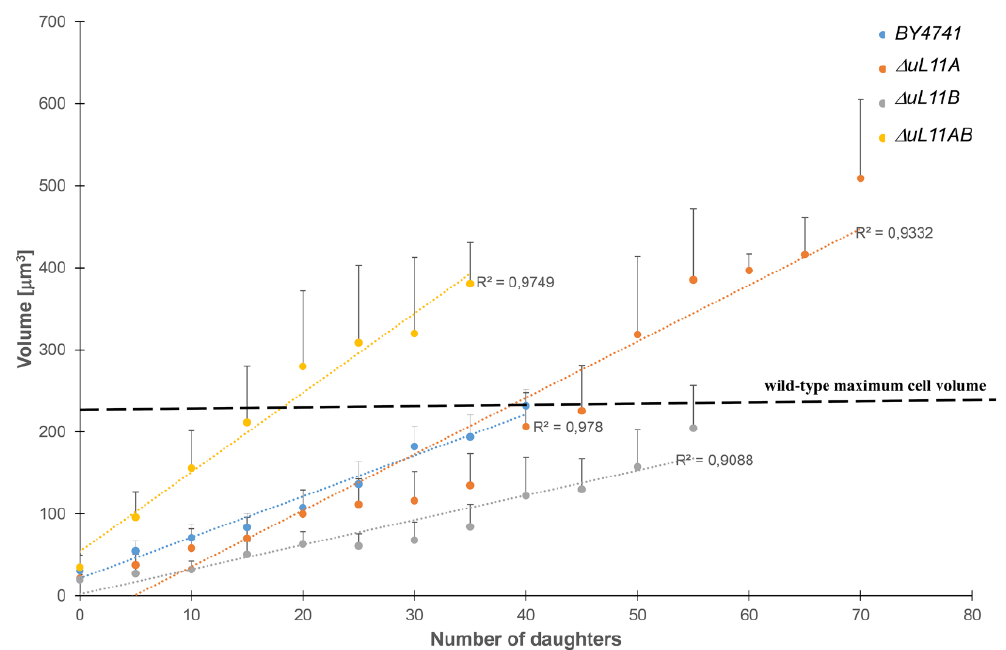
Figure 6. Dependence of the cell volume on the number of daughter cells produced by mother yeast cells. Changes in the cell size during the yeast reproductive lifespan were estimated by analysis of microscopic images recorded every fifth cell cycle during the determination of the budding lifespan. The results represent values for all cells tested in two independent experiments (90 cells). The bars indicate standard deviations.